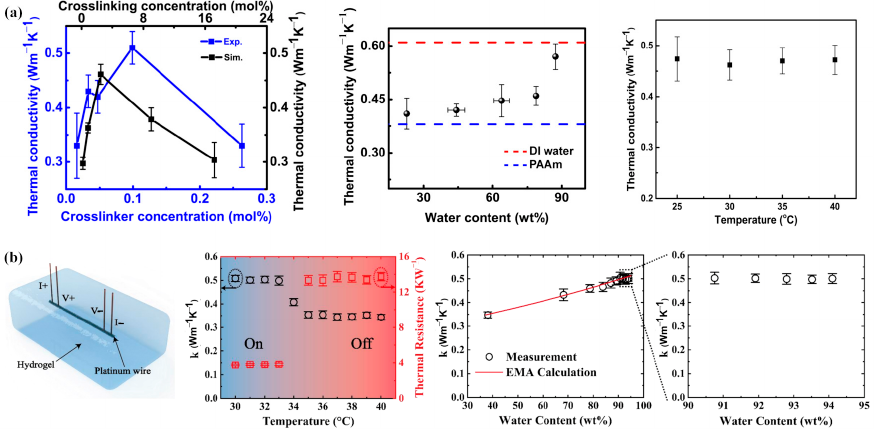
Figure 13. Thermal conductivity of hydrogels for electronic devices applications: ( a ) Thermal conductivity of PAM hydrogels; ( b ) Thermal conductivity of thermal switch based on PNIPAM hydrogels. Reprinted with permission from [133,137].